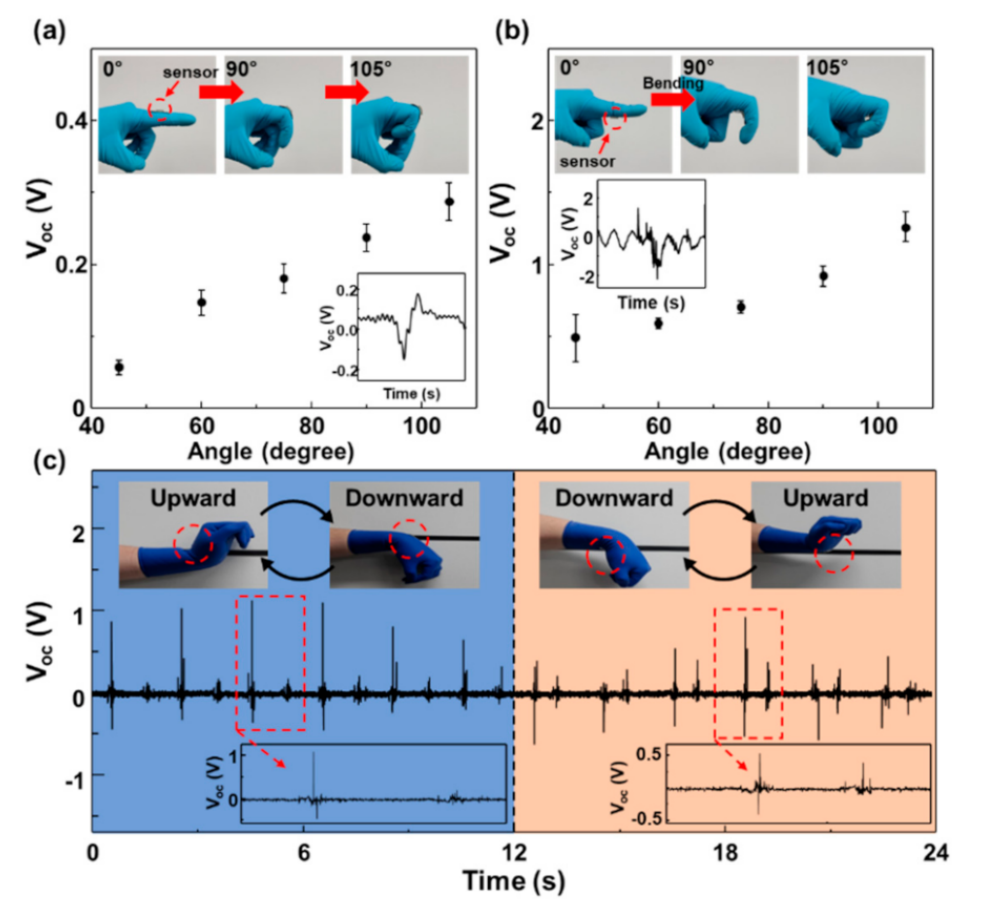
Figure 4. Output voltages of the attached on the ( a ) top and ( b ) bottom side of the proximal interphalangeal (PIP) with bending. ( c ) Output voltages of the attached on the top and bottom side of the wrist and detecting bending